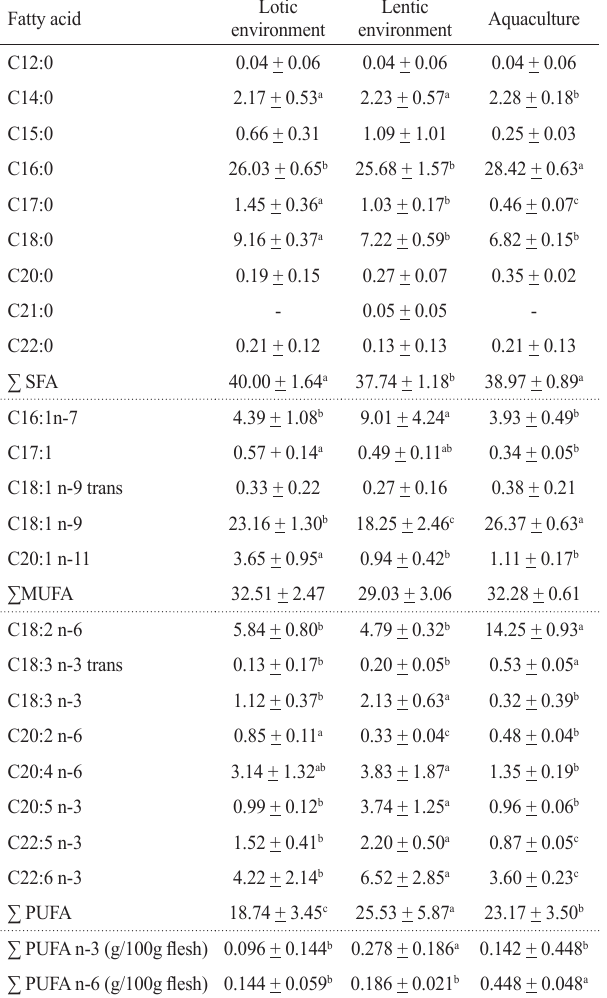
Tab. 3. Chemical and fatty acid composition of feed. Mean ±